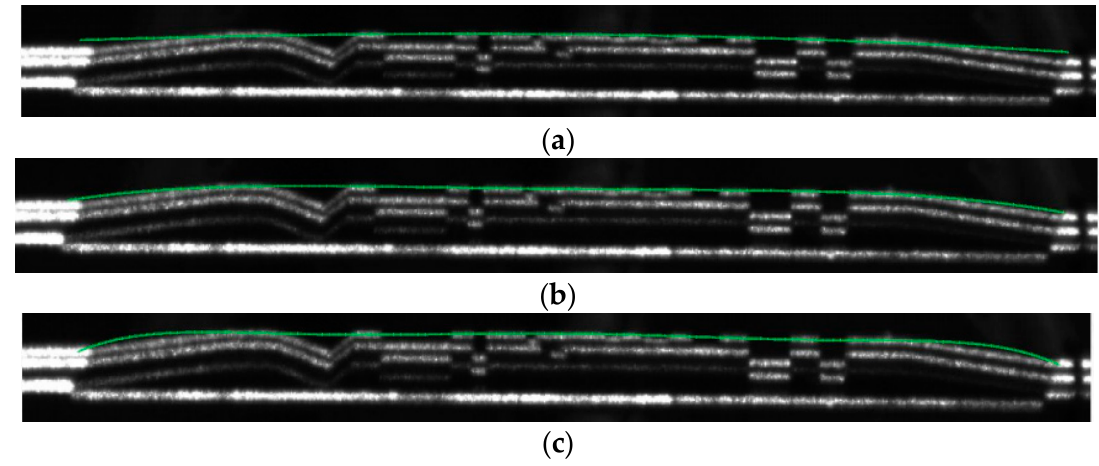
Figure 13. Fitted lines obtained by applying polynomials of the ( a ) third, ( b ) fifth, and ( c ) sixth degrees in the estimation method.